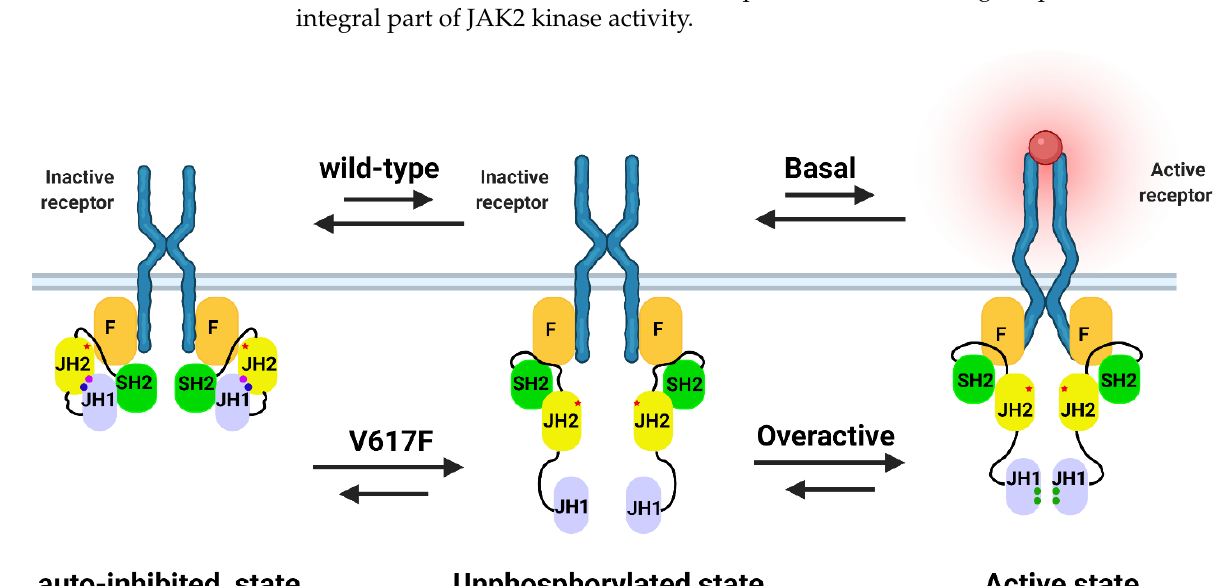
Figure 3. Model of the interactions between the domains of the JAK2 protein. The three main states of JAK2 include auto-inhibited state, unphosphorylated state, and active state. In the auto-inhibited state, the protein with phosphorylated S523 (pS523) and phosphorylated Y570 (pY570) are locked in the inactive conformation. The unphosphorylated state is a transition between the active and inactive conformations. In the active state, the two JAK2 molecules associated with a cytokine receptor dimer are maintained in positions that trans-phosphorylation of the JH1 activation loop, including Tyr1007 and Tyr1008. The pS523 is drawn as a blue dot, the pY570 is drawn as a red dot, the V617F mutation is drawn as a red star, and the pY1007/1008 is drawn as green